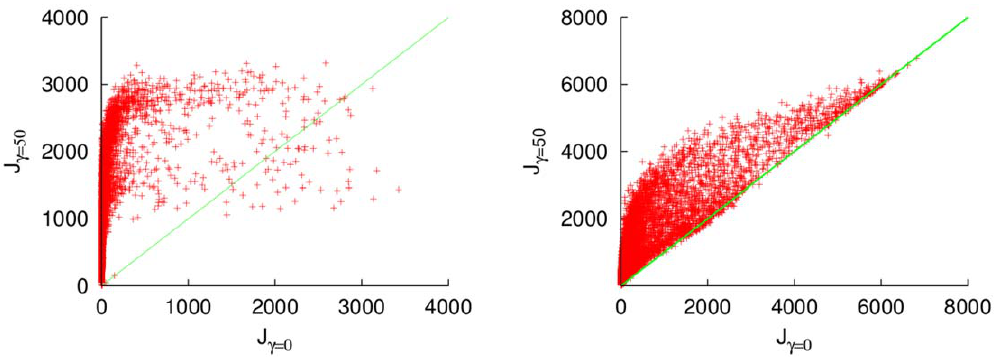
Figure 6. Energy flux for random Hamiltonians normally distributed around the FMO Hamiltonian, for n ~ 1 (left) and n ~ 100 (right). The y -axis represents the energy flux under a dephasing channel with c ~ 50 and the x -axis represents the energy flux without dephasing. The green line represents the space where both fluxes are equal. Units of cm { 1 .